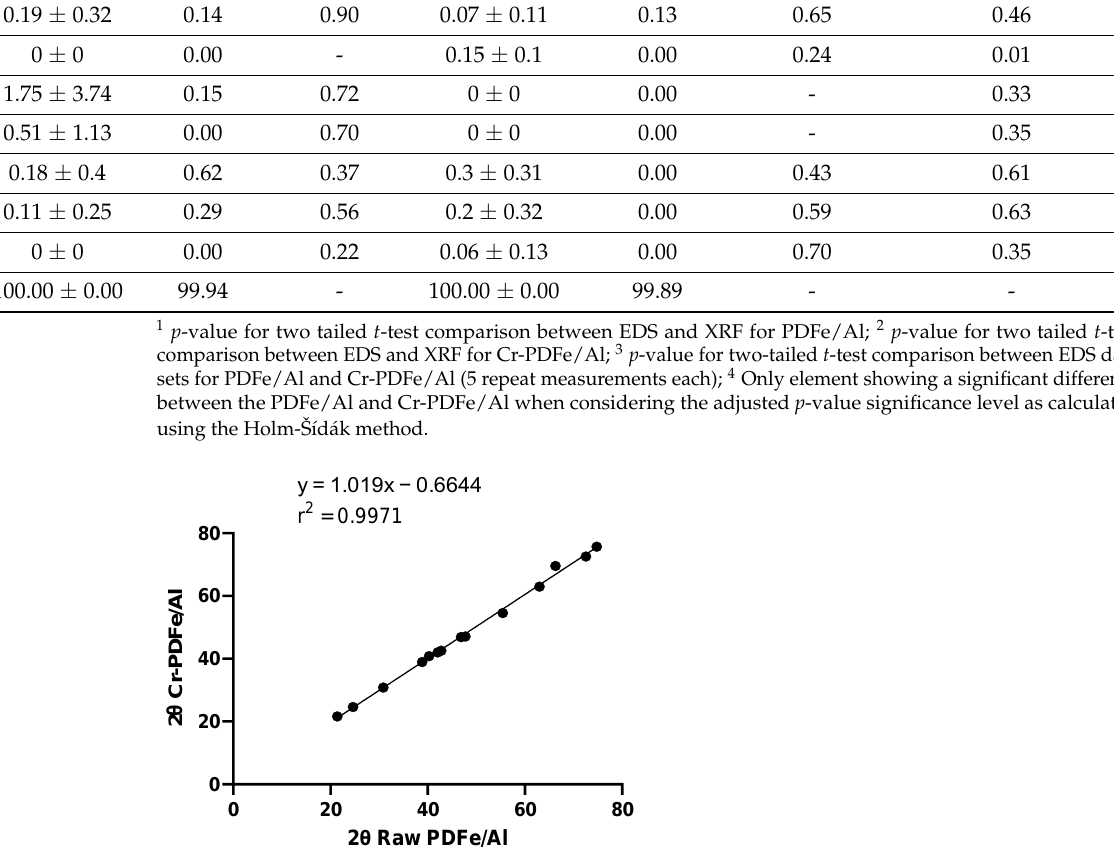
Figure 4. 2 θ values for PDFe/Al before and after Cr(VI) adsorption. Figure 4. 2θ values for PDFe/Al before and after Cr(VI) adsorption. The increased total surface area implies that the adsorbed chemical has the potential As indicated in Figure 4, the plot for 2θ values for PDFe/Al before and after Cr(VI) usage after Cr(VI) ion adsorption shows a clear shift in 2θ values of 0.66° thus confirming internal adsorption induced strains as previously reported in Muedi et al. 2022 [2]. Table 3. EDS and XRF mole percentage results.